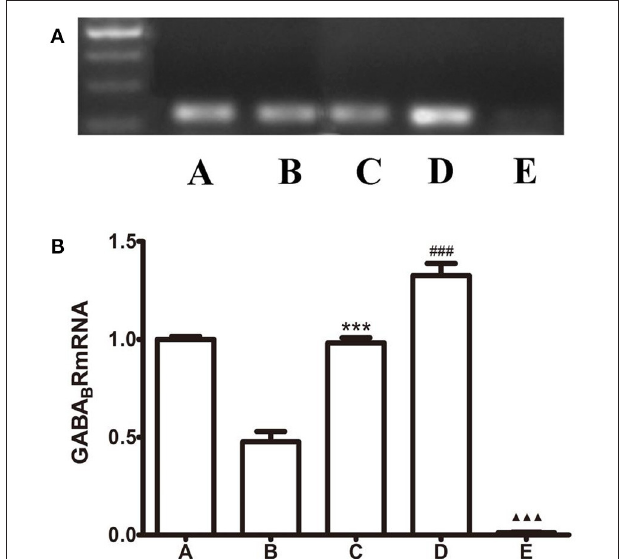
FIGURE 5 | Protein expression of P -GABA B receptor in the LHA. (A) Western blot analysis of expression of P -GABA B receptor. (B) Quantitative analysis of P -GABA B receptor expression in the LHA. β -action was used as a loading control. *** P < 0.001, as compared with the GI-R group; ### P < 0.001, as compared with the GI-R group; NNN P < 0.001, as compared with the GI-R group. A, Normal group; B, GI-R group; C, FN + GI-R + L -Glu group; D, LHA + GI-R + Baclofen group; E, LHA + GI-R + CGP35348 group. n = 5.